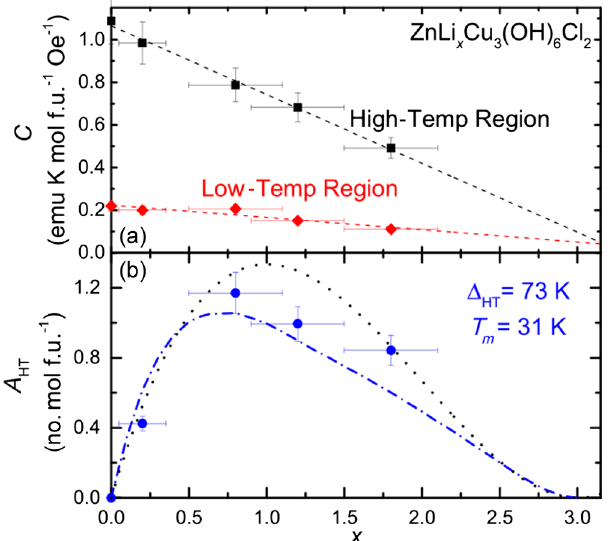
FIG. 4. Magnetization and heat capacity fit parameters. (a) The extracted Curie constants C from the high-temperature (black squares) and low-temperature (red diamonds) Curie-Weiss analy- sis of the ZnLi x Cu 3 ð OH Þ 6 Cl 2 series. The dashed lines are a guide to the eye that demonstrate a linear decrease. (b) The Schottky anomaly parameter A (blue circles) from heat capacity fits to HT the doped herbertsmithite series, which describes the feature in the high-temperature heat capacity data. The blue dashed line and the black dotted line are two different models for singlet trapping in doped herbertsmithite (see SM